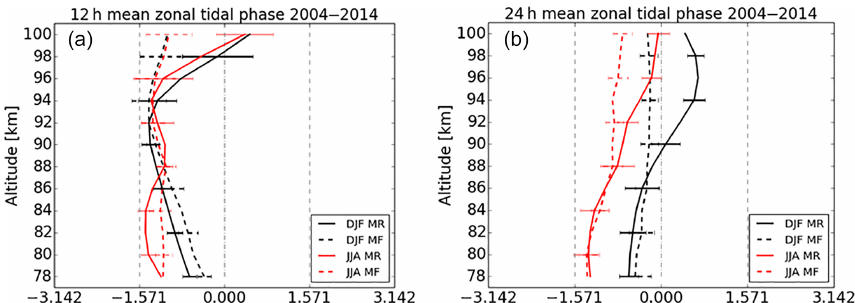
Figure 6. Vertical mean phase structure for the summer and winter seasons between 2004 and 2014. Semidiurnal (a) and diurnal tidal phases (b) of the zonal wind component for winter (DJF; in black) and summer (JJA; in red) for the meteor radar (solid) and the medium-frequency radar (dashed). The error bars show the variability in all seasons compared to the